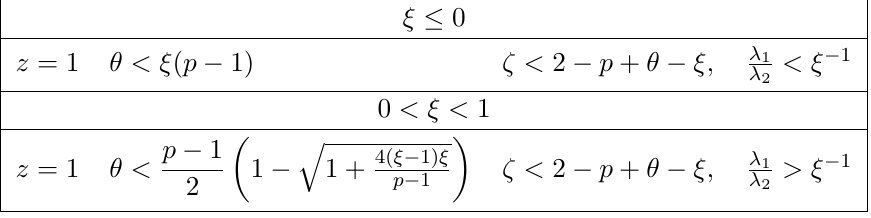
Table 10. Parameter range: Class II-ii, V 0 >